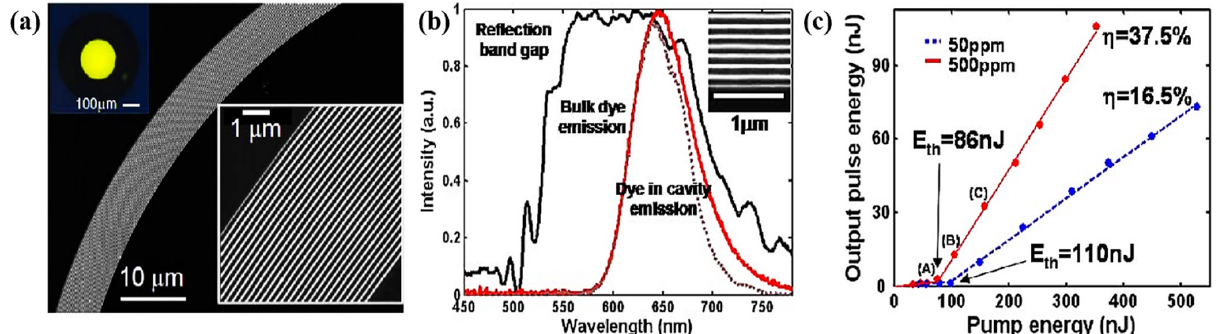
Figure 9. PBG fiber laser (Reprinted with permission from ref. [121]. Copyright 2006 Optical Society of America): ( a ) Fiber structure; ( b ) Fluorescence spectrum shown in red, and measured reflection band gap shown in black; ( c ) Dependence of the laser energy on the pump energy.